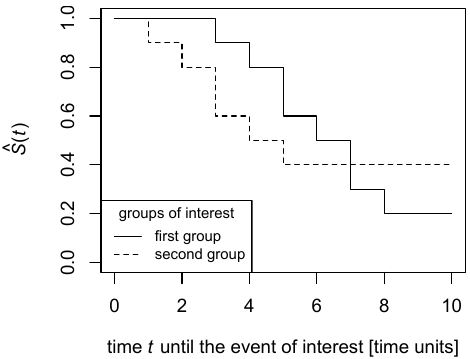
Figure 1. An example of two random survival curves crossing each other.